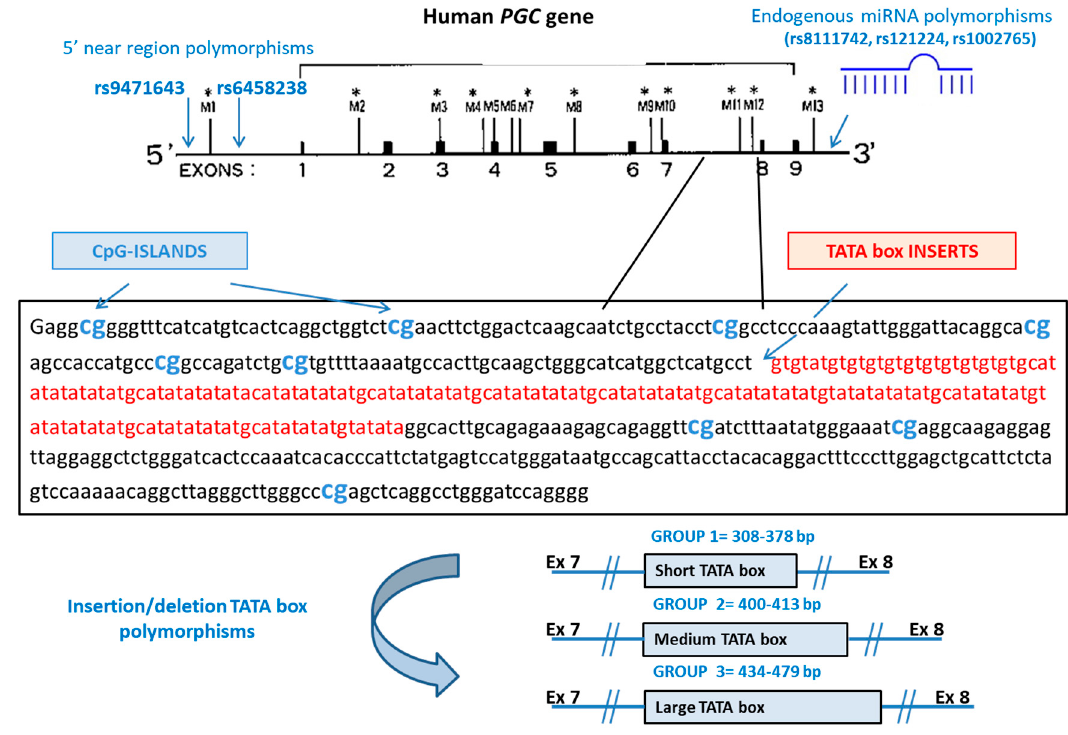
Figure 1. PGC (Progastricsin) gene, coding for the Pepsinogen II protein, structure and interactions with endogenous miRNAs tested in the study. The nine exons are indicated with black rectangles. * Potential methylation sites are indicated as M1 to M12. Different lengths of TATA box repeats (Group 1, short; Group 2, medium; Group 3, long) are present in the intronic region between exons 7 and 8, which includes two methylation sites (M11, M12) [29].